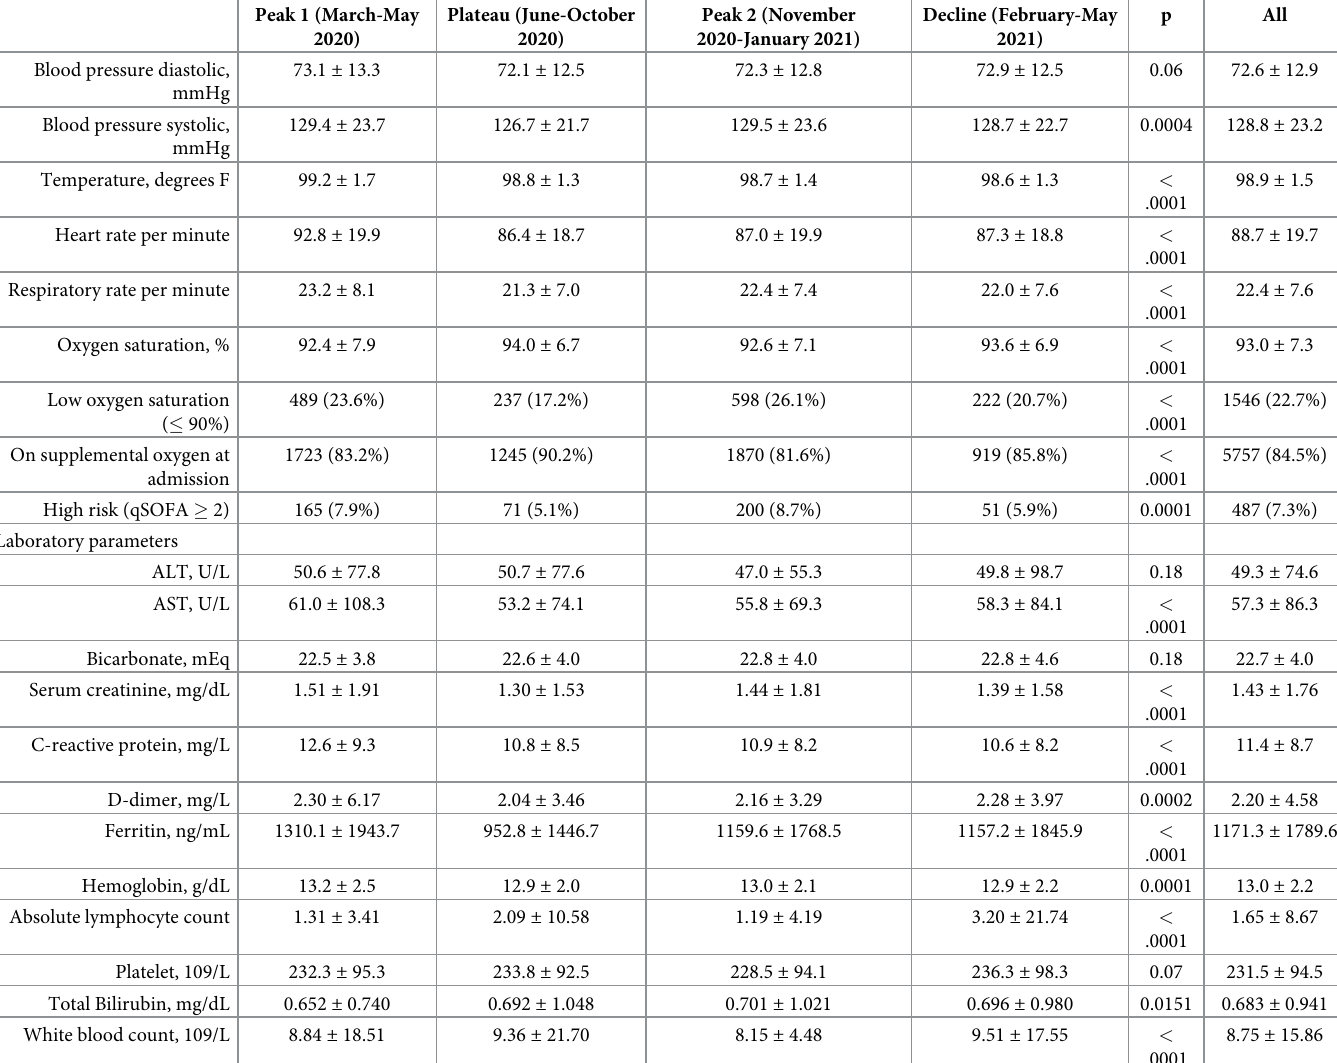
Table 2. Vital signs, symptoms and laboratory parameters on